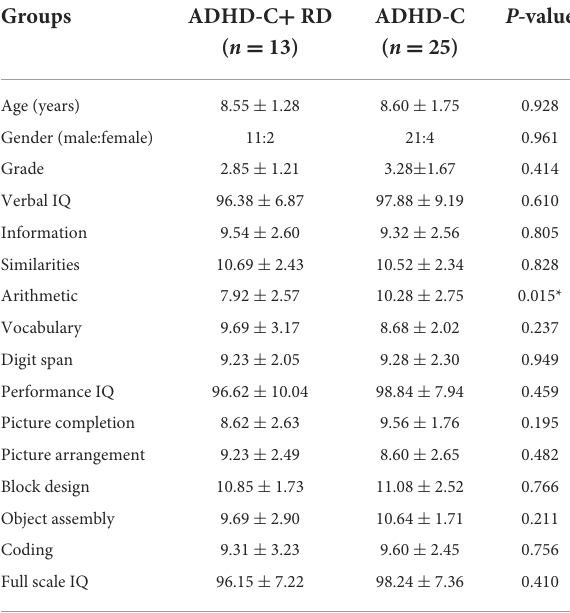
TABLE 2A Basic information of the ADHD-C + RD and ADHD-C subgroups. Groups